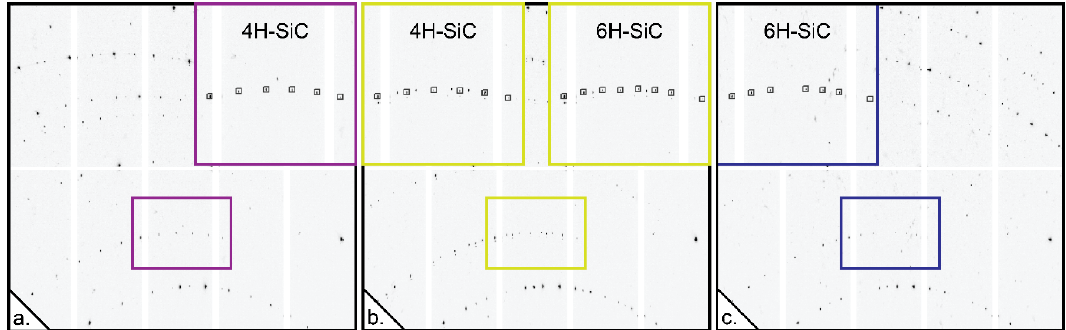
Figure 4. Di ff raction patterns from SiC1 can be indexed as either the 4H- or 6H-SiC. ( a ). This part of the sample indexes solely as 4H-SiC. The inset shows squares around all successfully identified peaks. No additional peaks remain. ( b ). This area can be indexed as both 4H- and 6H-SiC. The two insets show that all peaks are identified as being part of one or the other stacking type. ( c ). This pattern can be fully indexed as 6H-SiC, as seen in the inset.